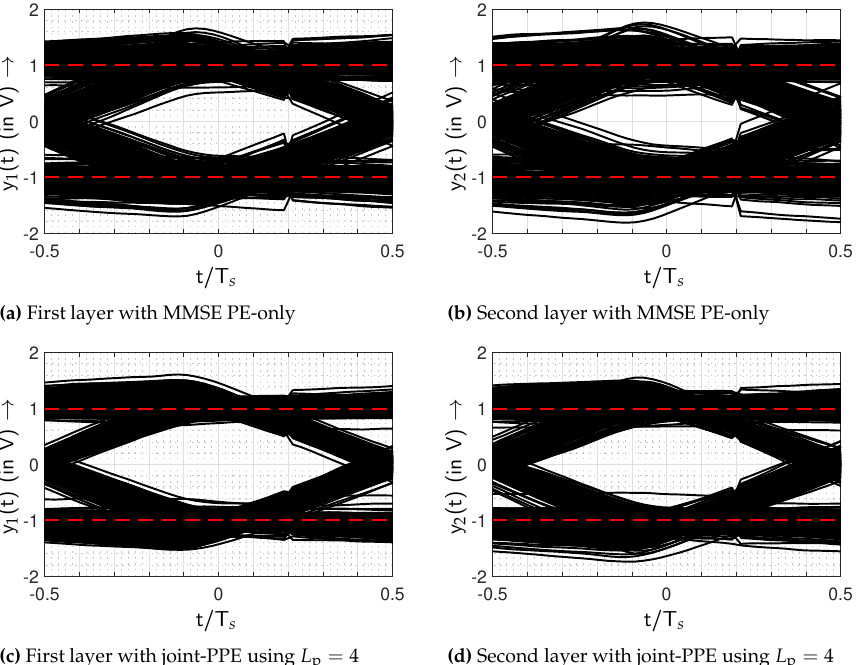
Figure 10. Eye diagrams of the joint-PPE with L p = 4 compared with MMSE PE-only using PAM-2 transmission.